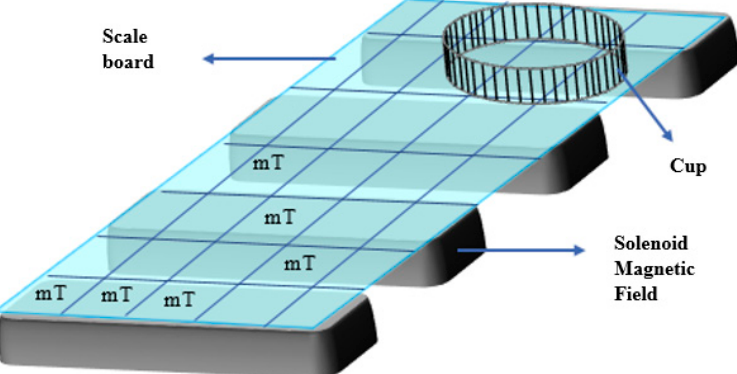
Figure 2. Schematic of scan position characterization of solenoid magnetic fi eld strength .